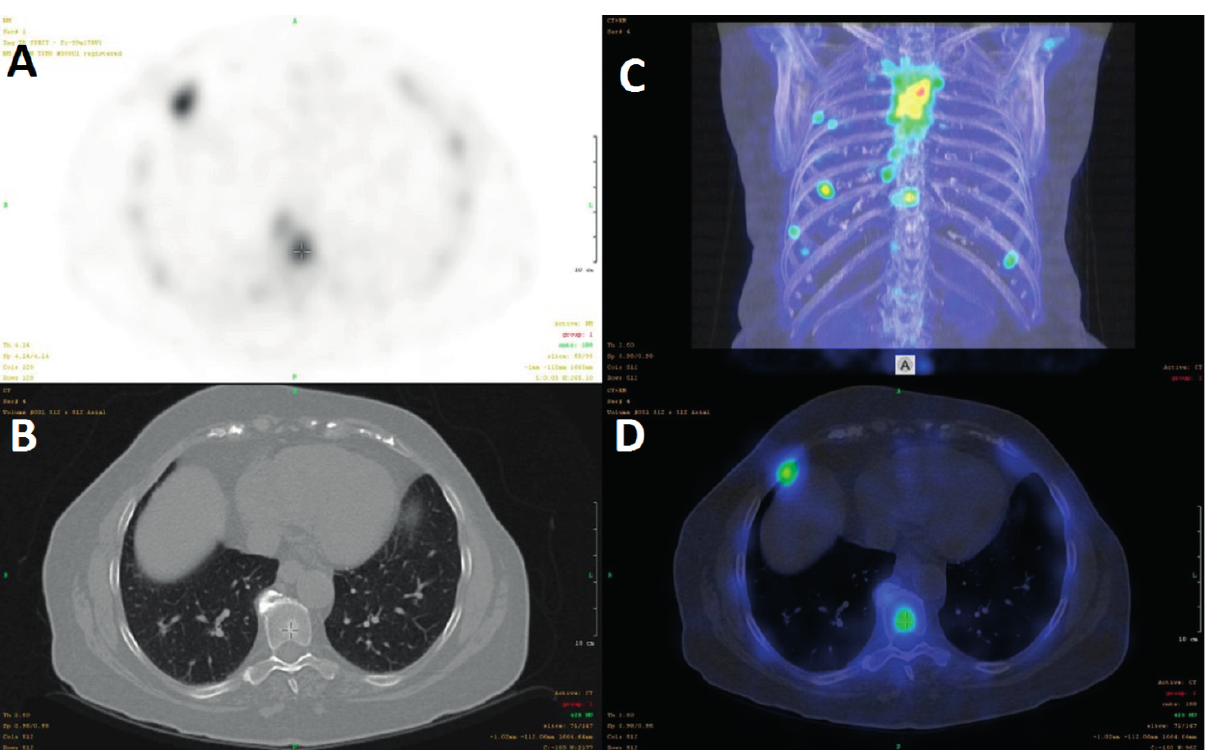
Fig. 2. Example of a poor fusion of metastasis in a rib during inspiration (false imaging of the focus outside the rib due to respira- tory movement) and a precise fusion of focus in the vertebral body (A) SPECT image, (B) CT image, (C) 3D volume rendering fused SPECT/CT image, (D) fused SPECT/CT